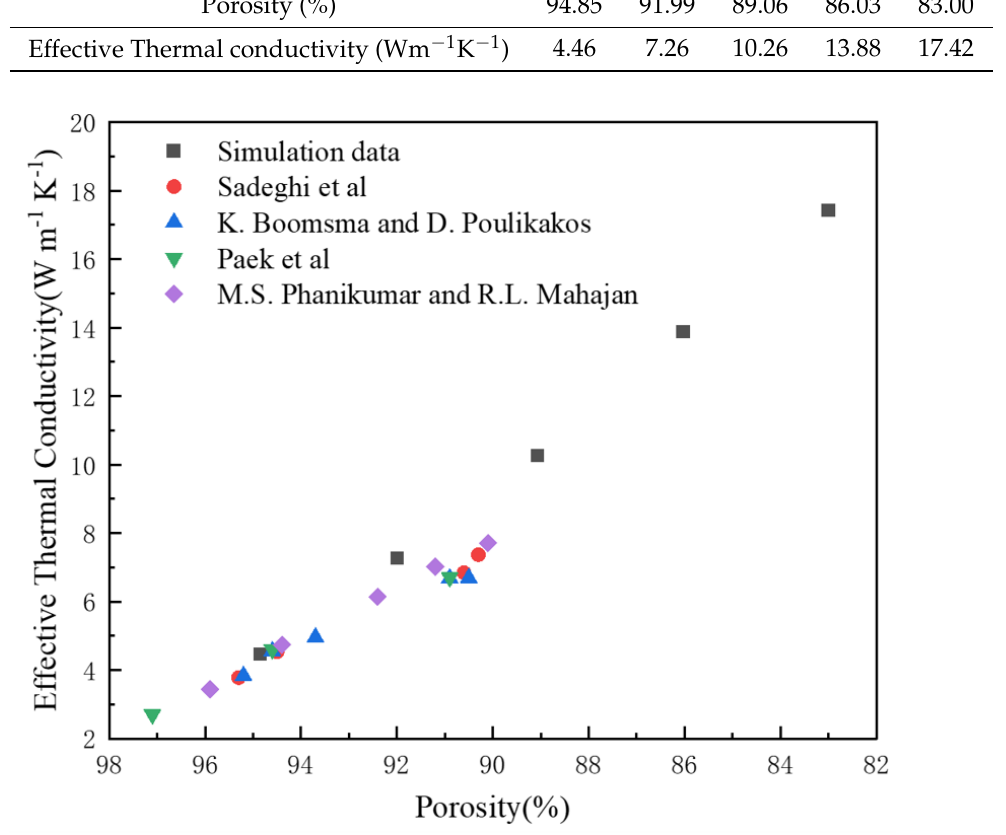
Figure 9. Comparison of simulation data and experimental data in the literature